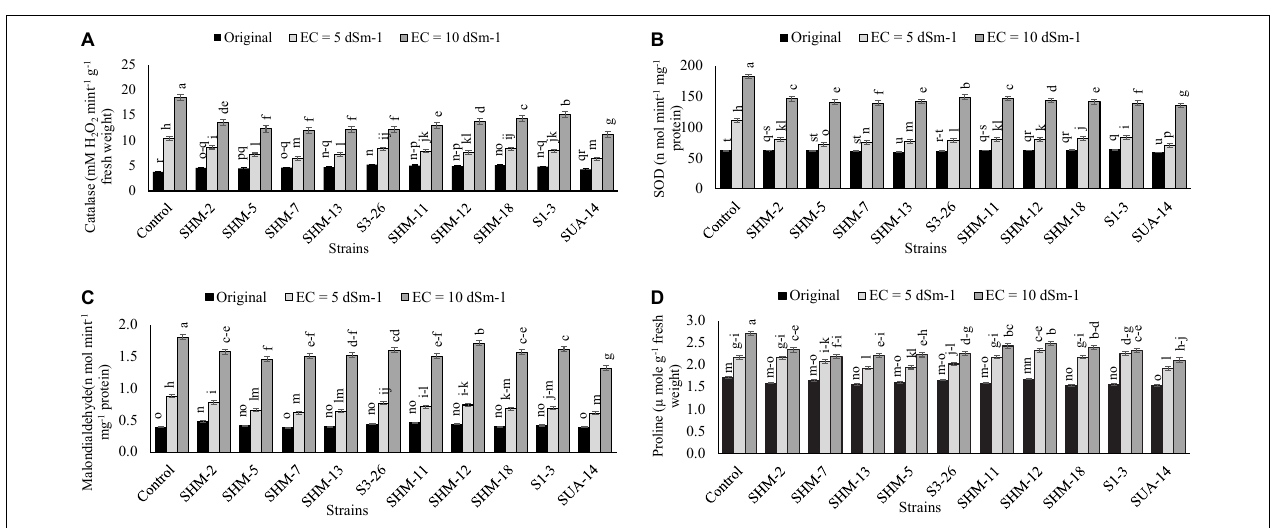
FIGURE 4 | Effect of rhizobacterial inoculation on the antioxidants, i.e., (A) catalase [mM hydrogen peroxide (H 2 O 2 ) mint − 1 g − 1 fresh weight], (B) superoxide dismutase (SOD) (n mol mint − 1 mg − 1 protein), (C) malondialdehyde (n mol mint − 1 mg − 1 protein), and (D) proline ( µ mole g − 1 fresh weight) activities of maize under salt-stressed pot conditions. Bars sharing the same letters are statistically non-significant at p ≤ 0.05.